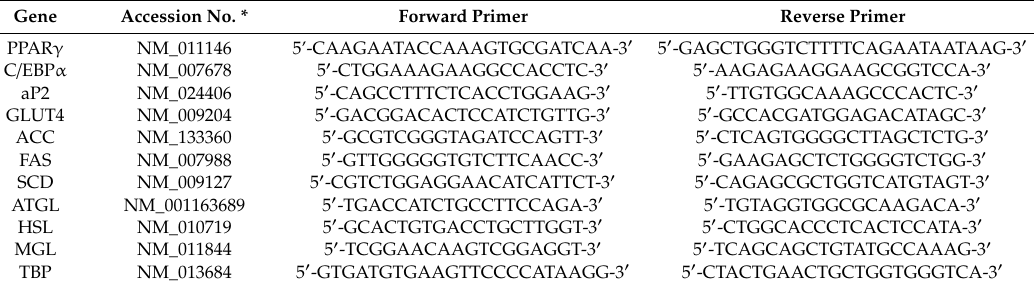
Table 1. Nucleotide sequences of primers used in quantitative